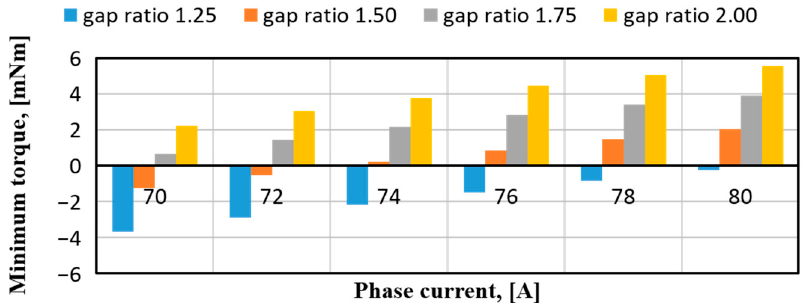
Figure 6. Minimum torque of tapered air gap with respect to length ratio and DC current.